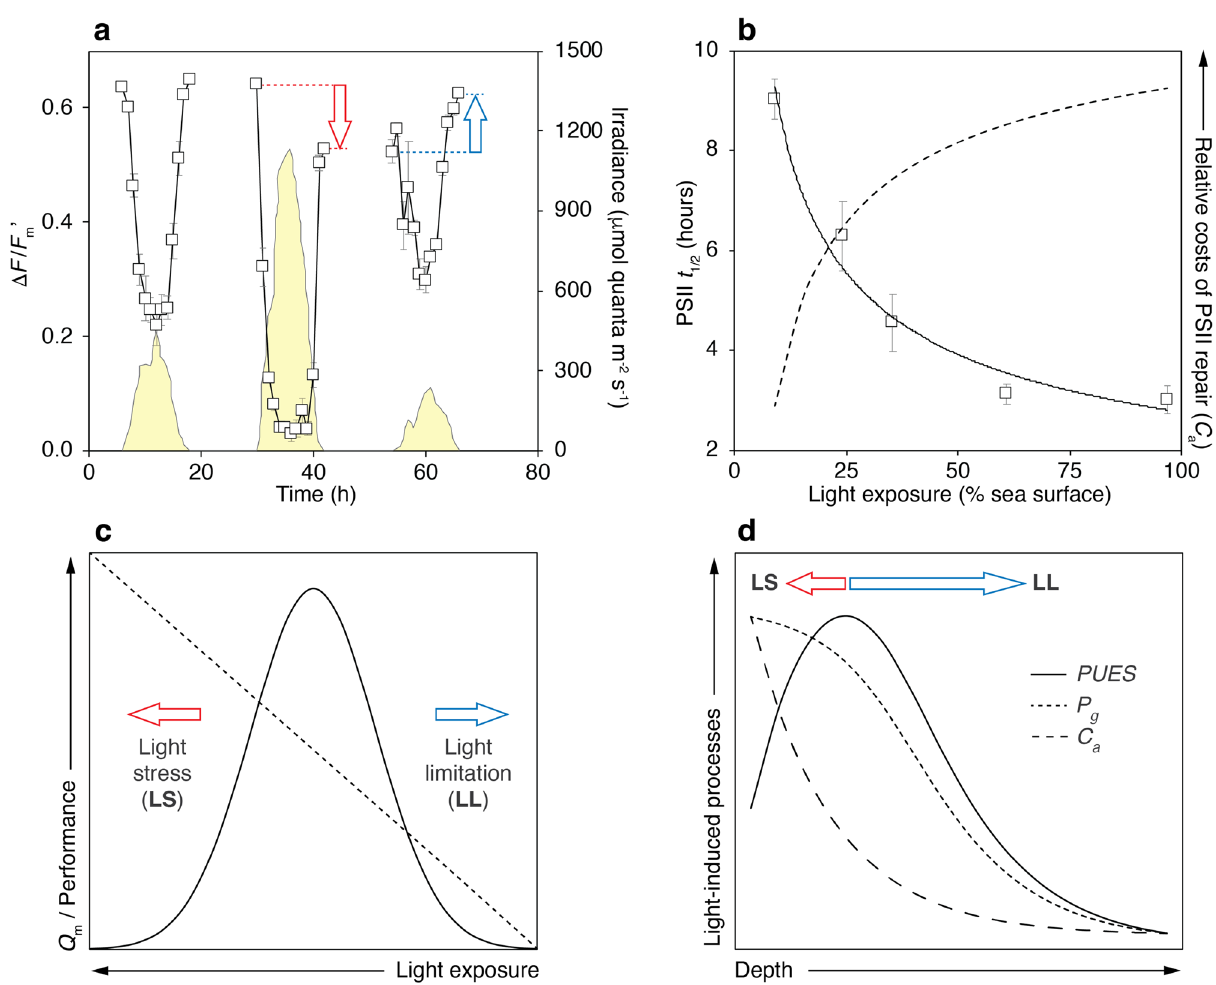
Figure 1. Principles and components of the coral productivity-biodiversity model. ( a ) Diurnal variation of Δ F / F m ’ in symbionts of Porites astreoides measured experimentally during a control-reference day (first day), and during days with increased (second day) and reduced light exposure (third day), emphasizing the consequences on the F v / F m recovery at the end of the diurnal cycle (arrows). The yellow shaded area represents the diurnal variation of irradiance ( E ). ( b ) Changes in the PSII t 1/2 in response to contrasting light exposure (in % of sea surface), fitting the data to a power function (continuous line). The dotted line indicates the relative energy cost of repairing photodamaged PSII by the symbiotic algae ( C a ) with light exposure, expected to be inversely proportional to the PSII t 1/2 . ( c ) Theoretical behavior of coral holobiont energetic performance (continuous line) in relation to Q m (discontinuous line) across a gradient of irradiance, highlighting the predicted effects of light stress (LS) and light limitation (LL) on coral holobiont energetic performance. ( d ) Schematic representation of the relative changes in light-induced processes affecting the energy balance of coral holobionts along a depth gradient. PUES : photosynthetic usable energy supply; C a energy costs of repair from photodamage for the algae; and P g : gross